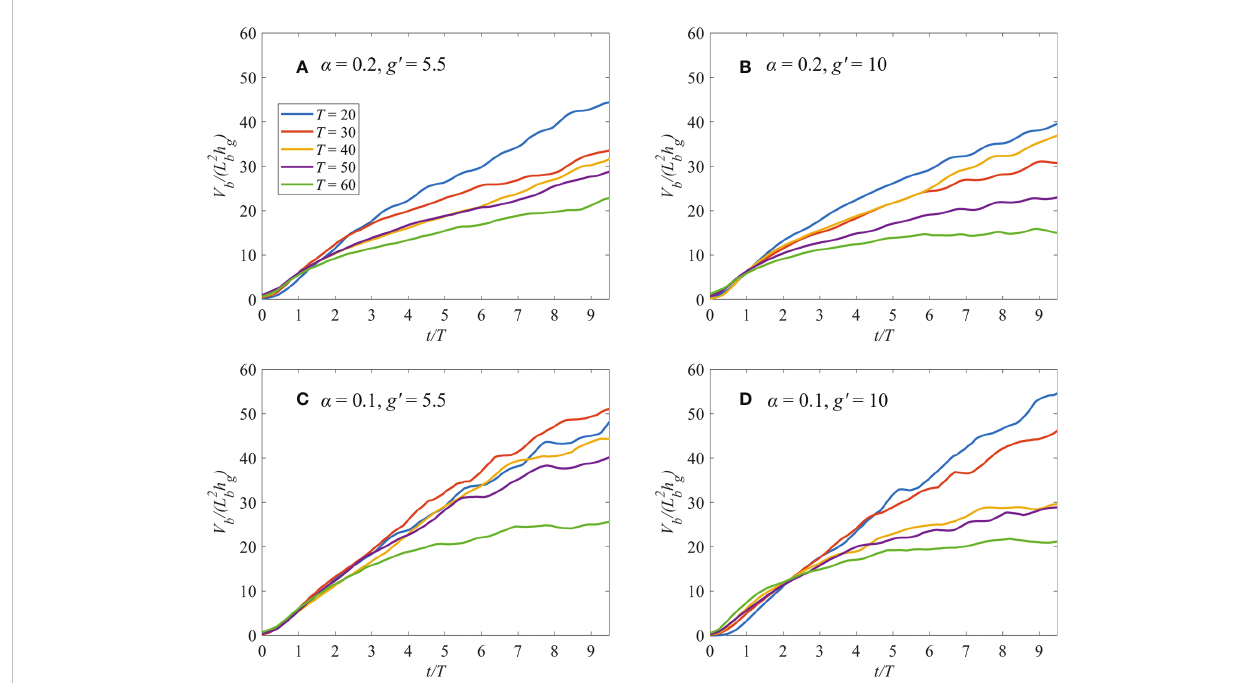
FIGURE 9 Time series of normalized bulge volume for different rotation rates. (A) Runs 11 – 15 ( a = 0.2, g ’ = 5.5 case). (B) Runs 21 – 25 ( a = 0.2, g ’ = 10 case). (C) Runs 31 – 35 ( a = 0.1, g ’ = 5.5 case). (D) Runs 41 – 45 ( a = 0.1, g ’ = 10